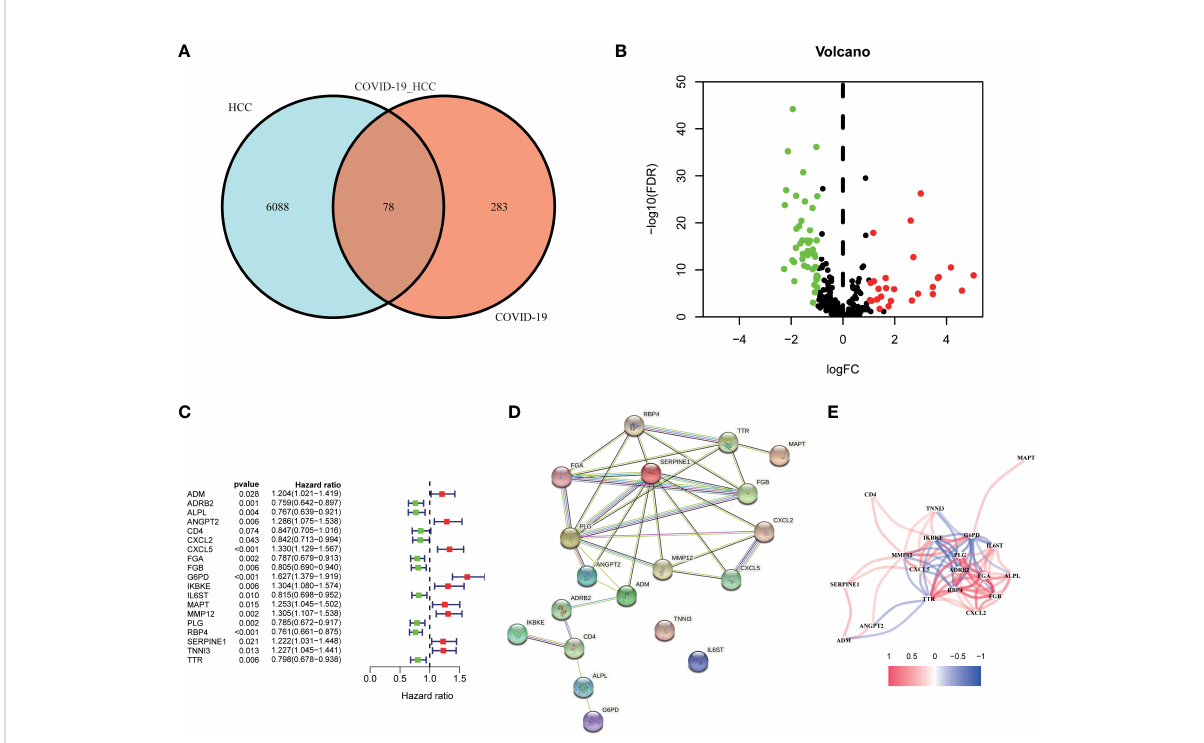
FIGURE 2 Identi fi cation of the candidate genes in COVID-19/HCC. (A) Venn diagram to identify the intersecting genes in COVID-19/HCC. (B) Volcano plot of the intersecting genes in HCC. (C) The results of the univariate Cox analysis presented in a forest plot. (D) The interaction network among the 19 COVID-19/HCC related genes. (E) The correlation network of the 19 COVID-19/HCC related